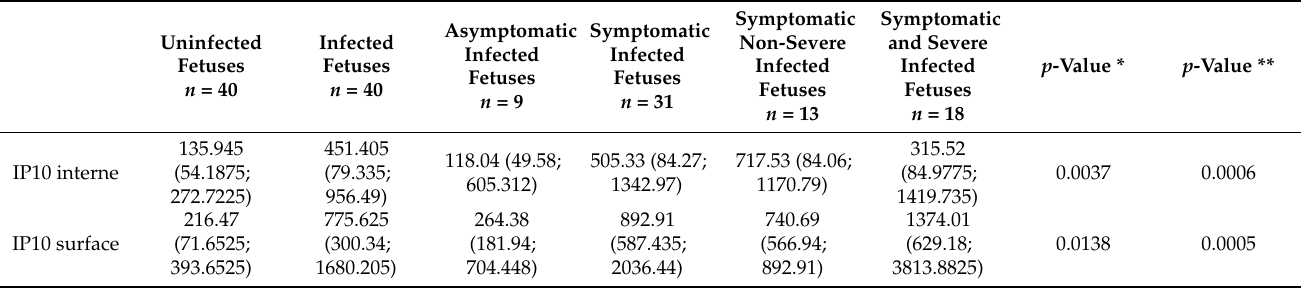
Table 2. Concentrations of relevant cytokines according to fetal infection (median and